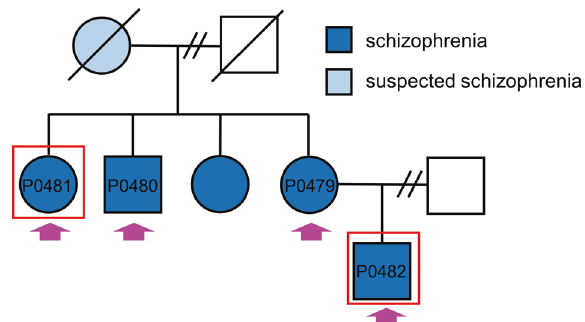
Fig. 1 Pedigree of a family with schizophrenia. We performed whole-exome sequencing on four patients (P0479, P0480, P0481, and P0482) indicated by pink arrows. iPSCs were generated from two patients (P0481 and P0482) indicated by red boxes. Blue and light blue represent patients with schizophrenia and suspected schizophrenia,